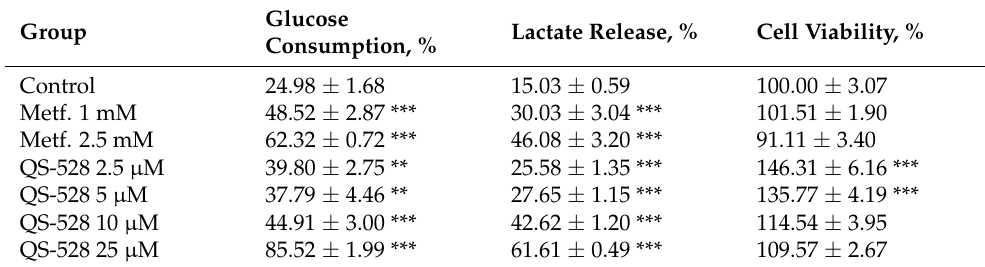
Table 2. Effect of the QS-528 compound on the HepG2 cell line. Group